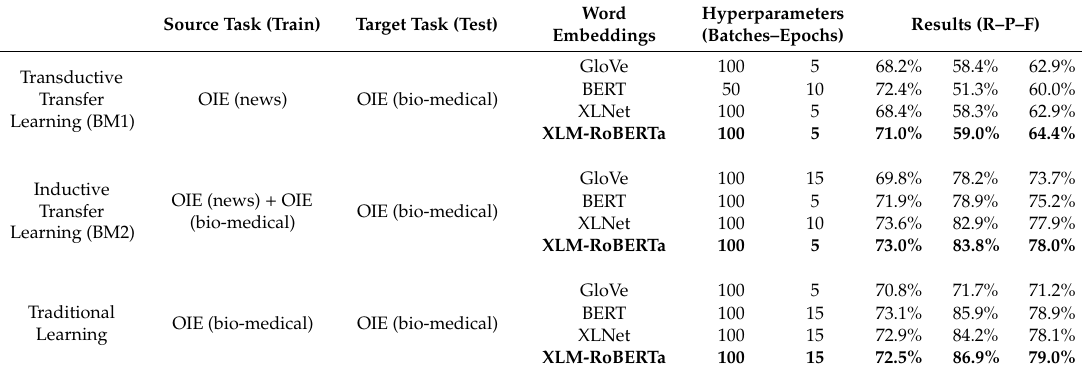
Table 7. Domain adaptation results by transferring from the OIE news domain to the OIE bio-medical domain using four different word embeddings. Bold values indicate the highest achieved F-measure in each of the three experiments (transductive transfer learning, inductive transfer learning, traditional